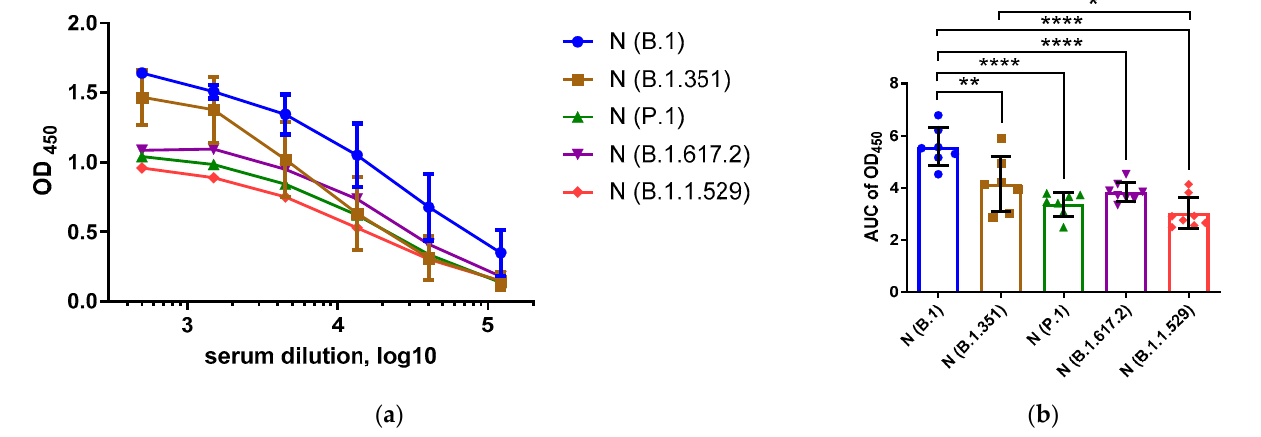
Figure 1. Assessment of homologous anti ‐ N antibody levels in serum samples of mice immunized with B.1 (blue), B.1.351(brown), P.1 (green), B.1.617.2 (magenta) and B.1.1.529 (red). Hereafter, the color designations of the N proteins of different SARS ‐ CoV ‐ 2 VOCs are the same. The OD 450 values are shown in ( a ), and the area under the OD 450 curve (AUC) values are shown in ( b ). These data were compared using ANOVA with the Tukey post hoc test. * p < 0.05, ** p < 0.01, **** p < 0.0001.